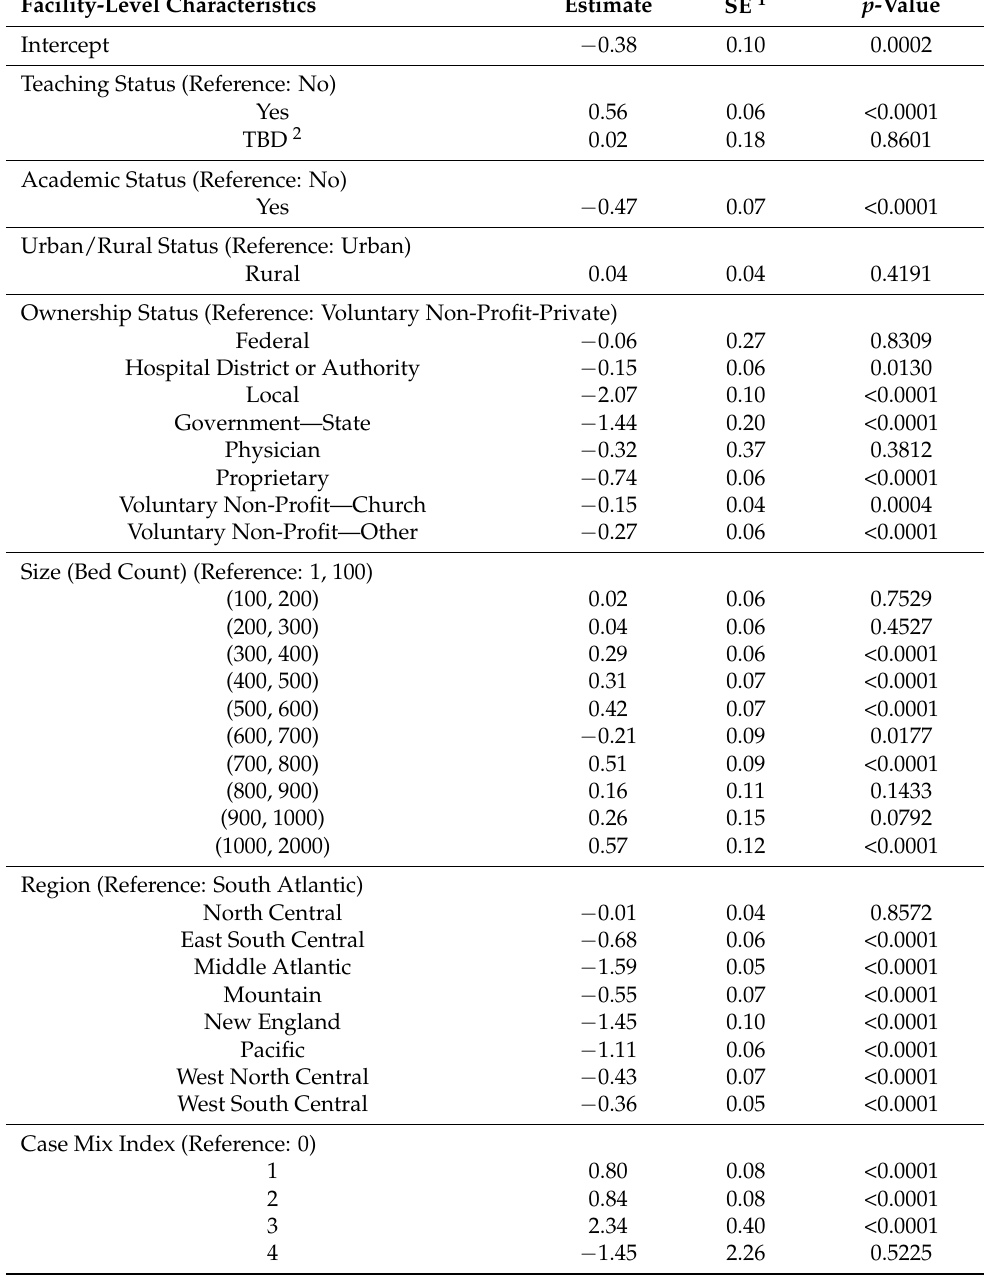
Table 3. Summary of linear regression analysis to estimate excess coding intensity adjusted for facility-level